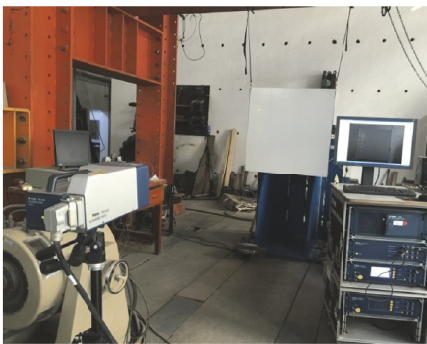
Figure9:Positionrelationshipbetweenthelaservibrometerandthe stiffened